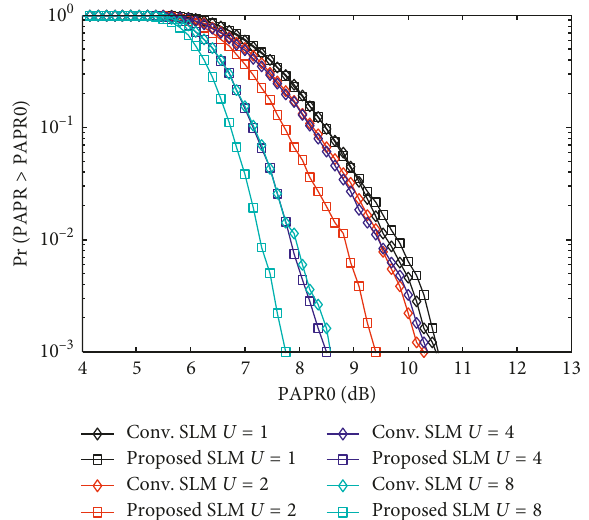
Figure 12: Comparison of SLM given in [5] with the proposed SLM for U � 1, 2, 4, and 8, N � 128, and 32-PSK. Figure 10: Comparison of SLM given in [5] with the proposed SLM